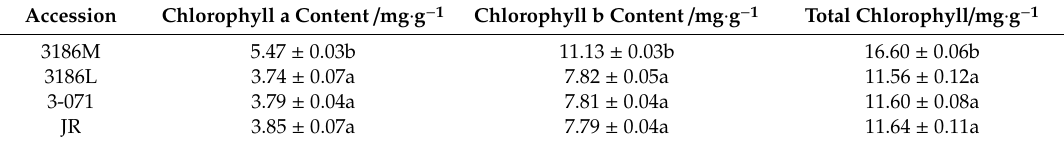
Table 2. Chlorophyll content of tomato accession seedlings in the six-leaf stage when treated with Botrytis cinerea. Among them, a and b represent di ff erent degrees of chlorophyll content. The values represent the average of three technical replicates ± SD. 3186M (tomato wo mutant, hairy), 3186L (tomato wo mutant, hairless), 3-071 (tomato ln mutant, hairless), JR (tomato cultivar Jia